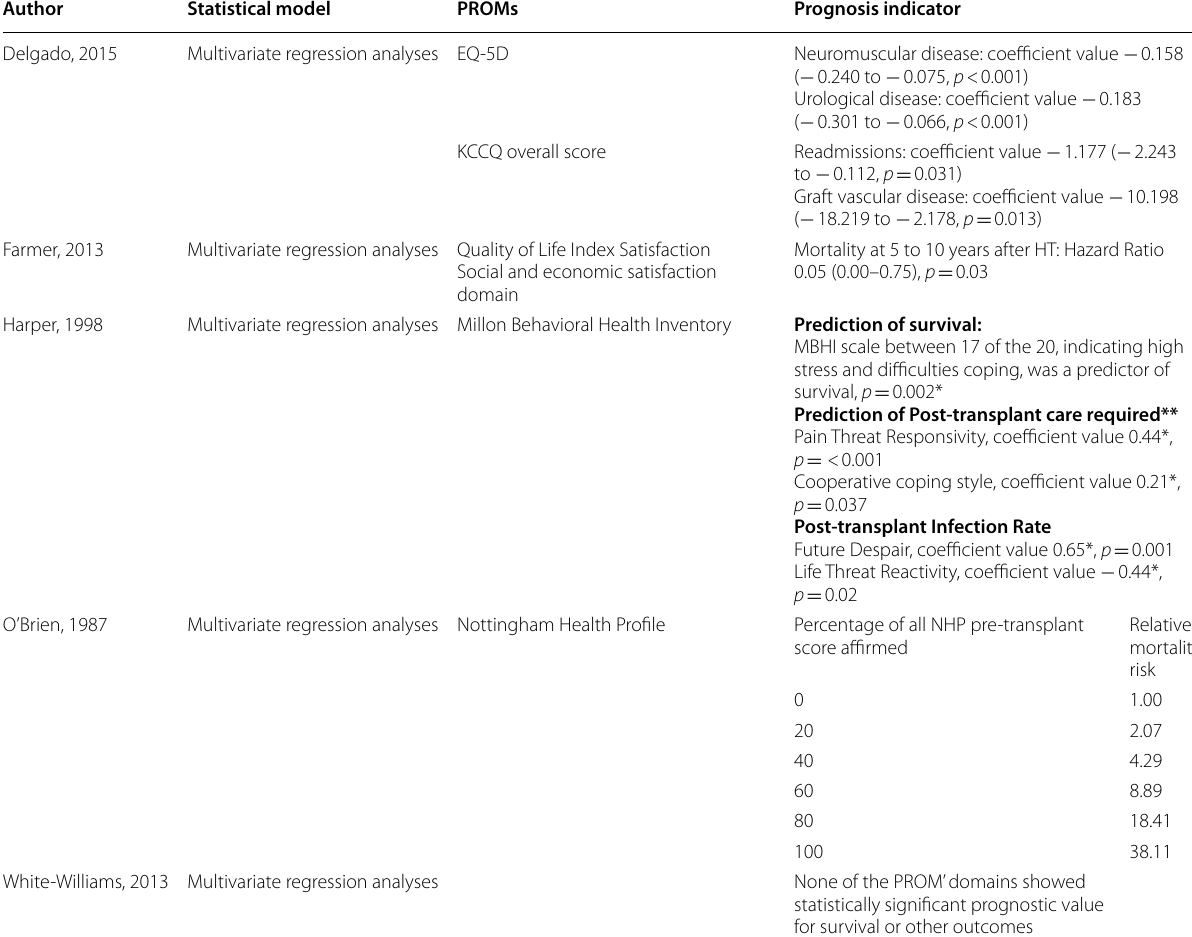
Table 5 PROMs as prognosis